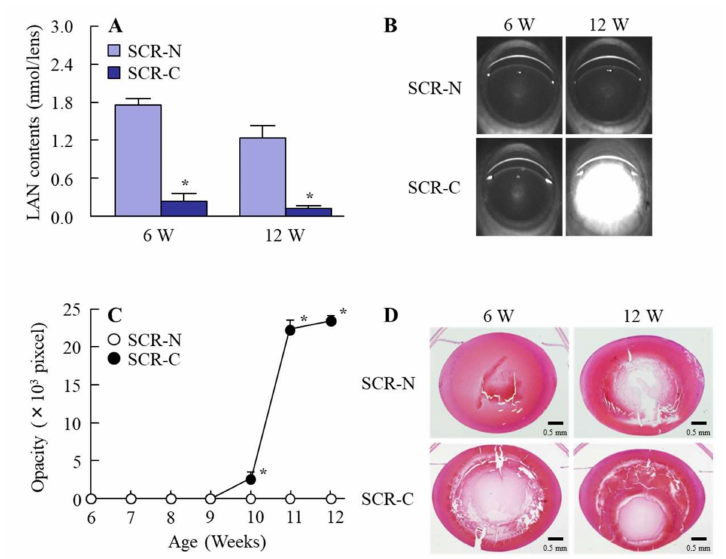
Figure 3. Lanosterol contents, opacity levels, and H&E images of the lenses of SCR-N and with the combination of a remarkable lens structure collapse and opacification (SCR-C) aged 6–12 weeks. ( A ) Lanosterol contents in the lenses of SCR-N and SCR-C. ( B , C ) Scheimpflug slit images (B) and opacification levels (C) in SCR-N and SCR-C. ( D ) H&E stained lens images of SCR-N and SCR-C. n = 5–8. * p < 0.05 vs. SCR-N for each group. The lanosterol levels in SCR-C were lower than those in SCR-N, and the lens opacification and posterior movement of the lens nuclei were observed in 12-week-old